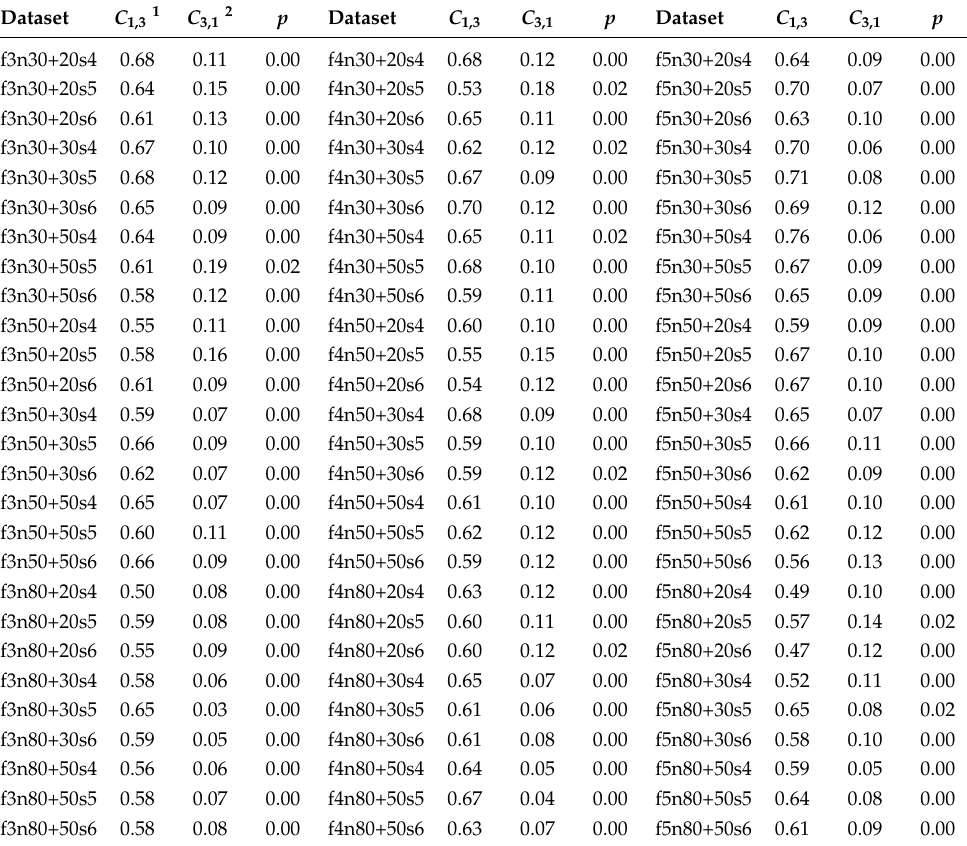
Table 5. Average C Metric Values of KCDE and